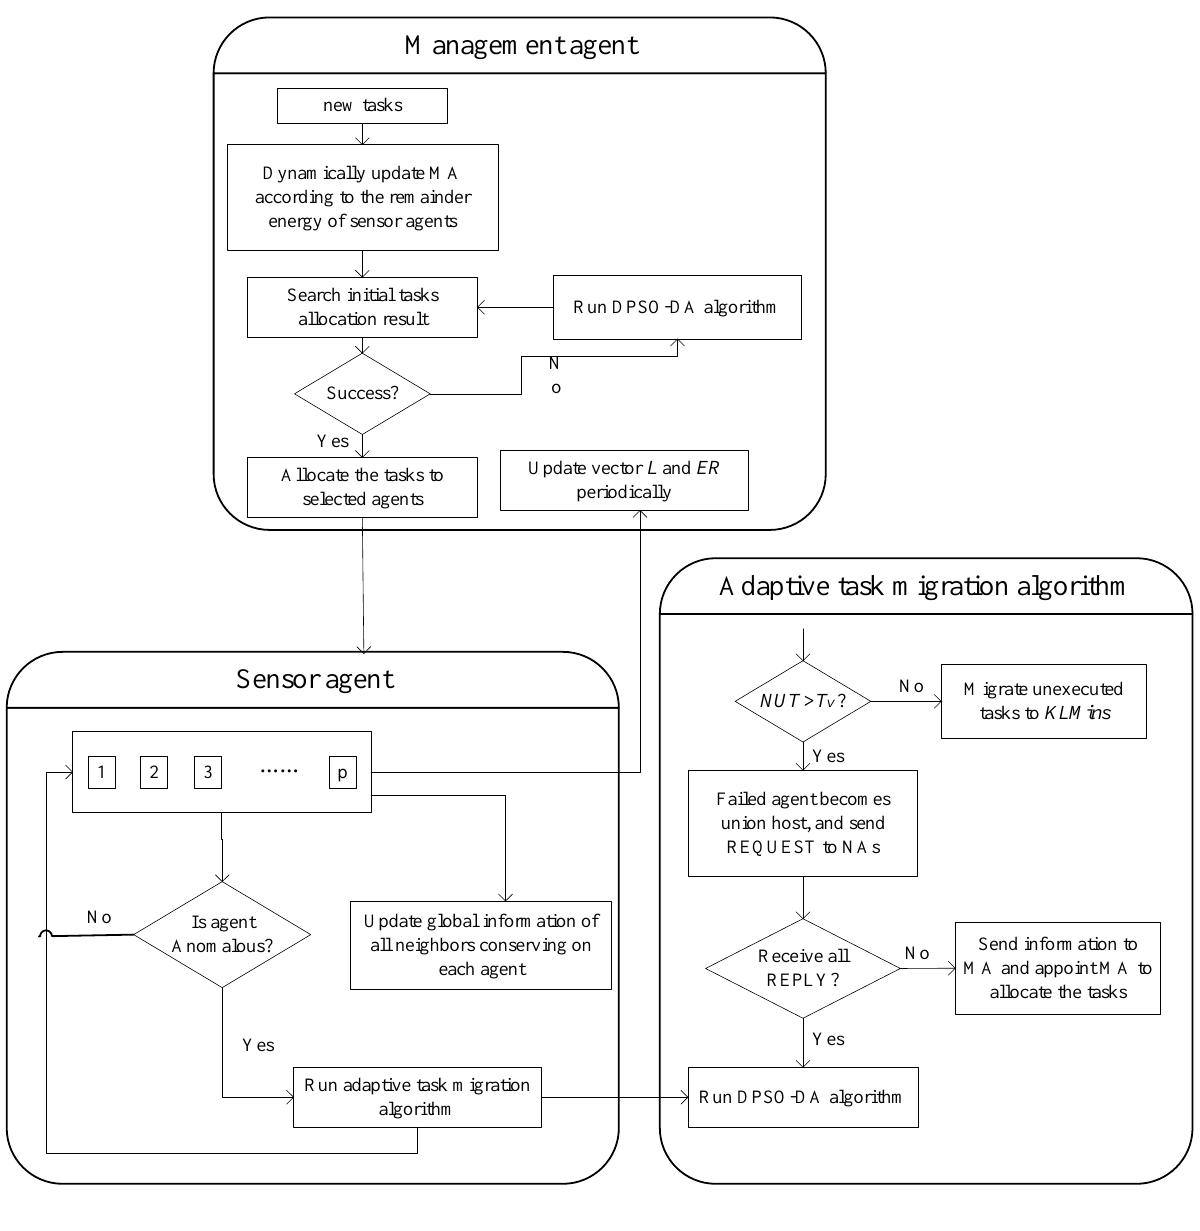
Figure 3. The self-adapted task allocation